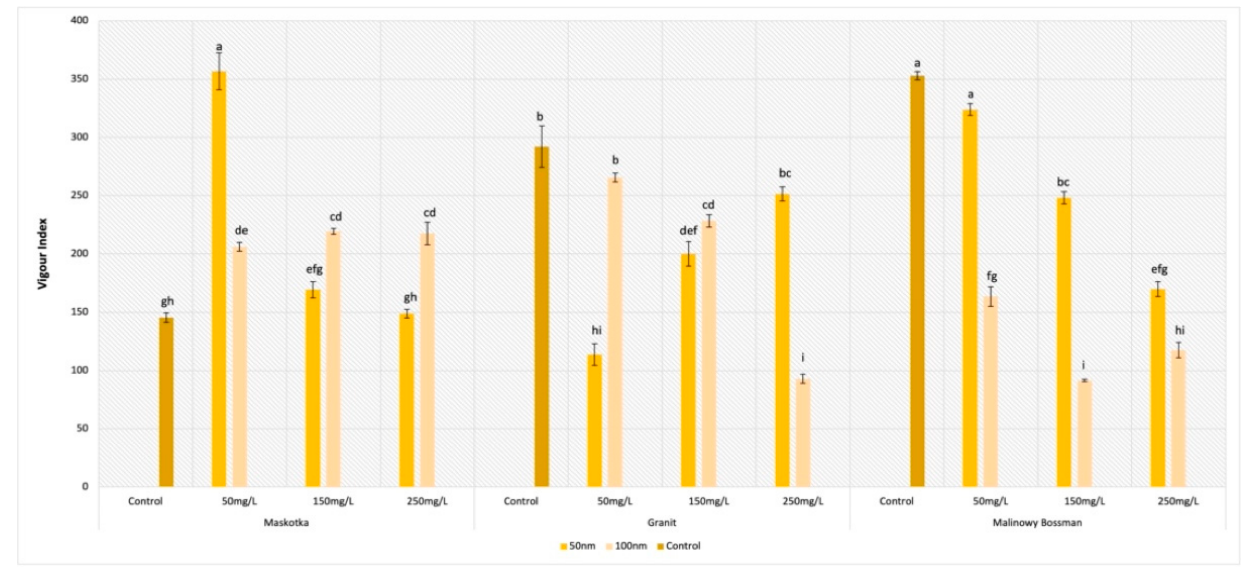
Figure 8. Effect of zinc oxide NPs on the vigor index germination of tomato seeds after 5 days of incubation. All data are the mean of 3 replicates and vertical bars demonstrate standard deviation (±SD). Different letters indicate the significant differences for p -value ≤ 0.05 (Table A6).